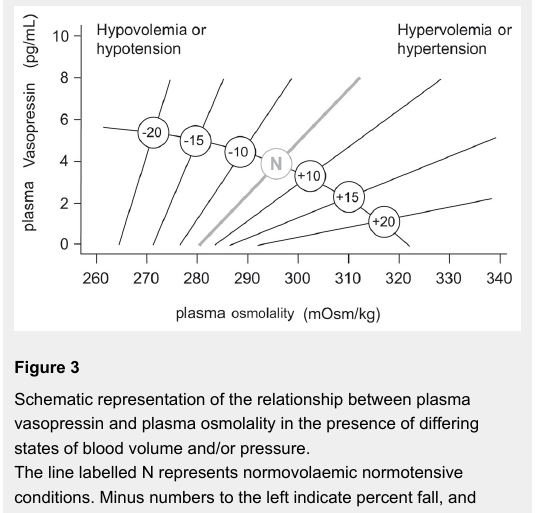
Structure of the human vasopressin (AVP) gene and cascade of vasopressin biosynthesis, signal peptide; AVP, arginine- vasopressin; neurophysin;